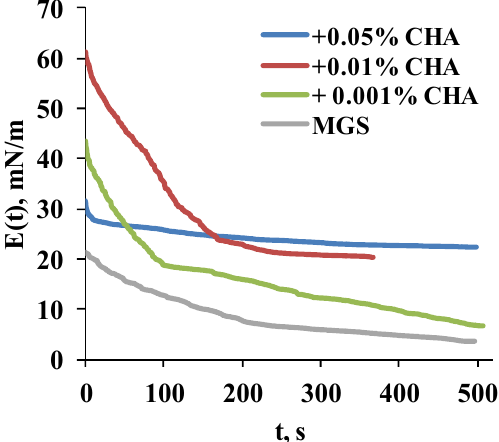
Figure 6. Relaxation transients of the transient elasticity modulus (mN/m) of meibomian layers, alone and in the presence of CHA.